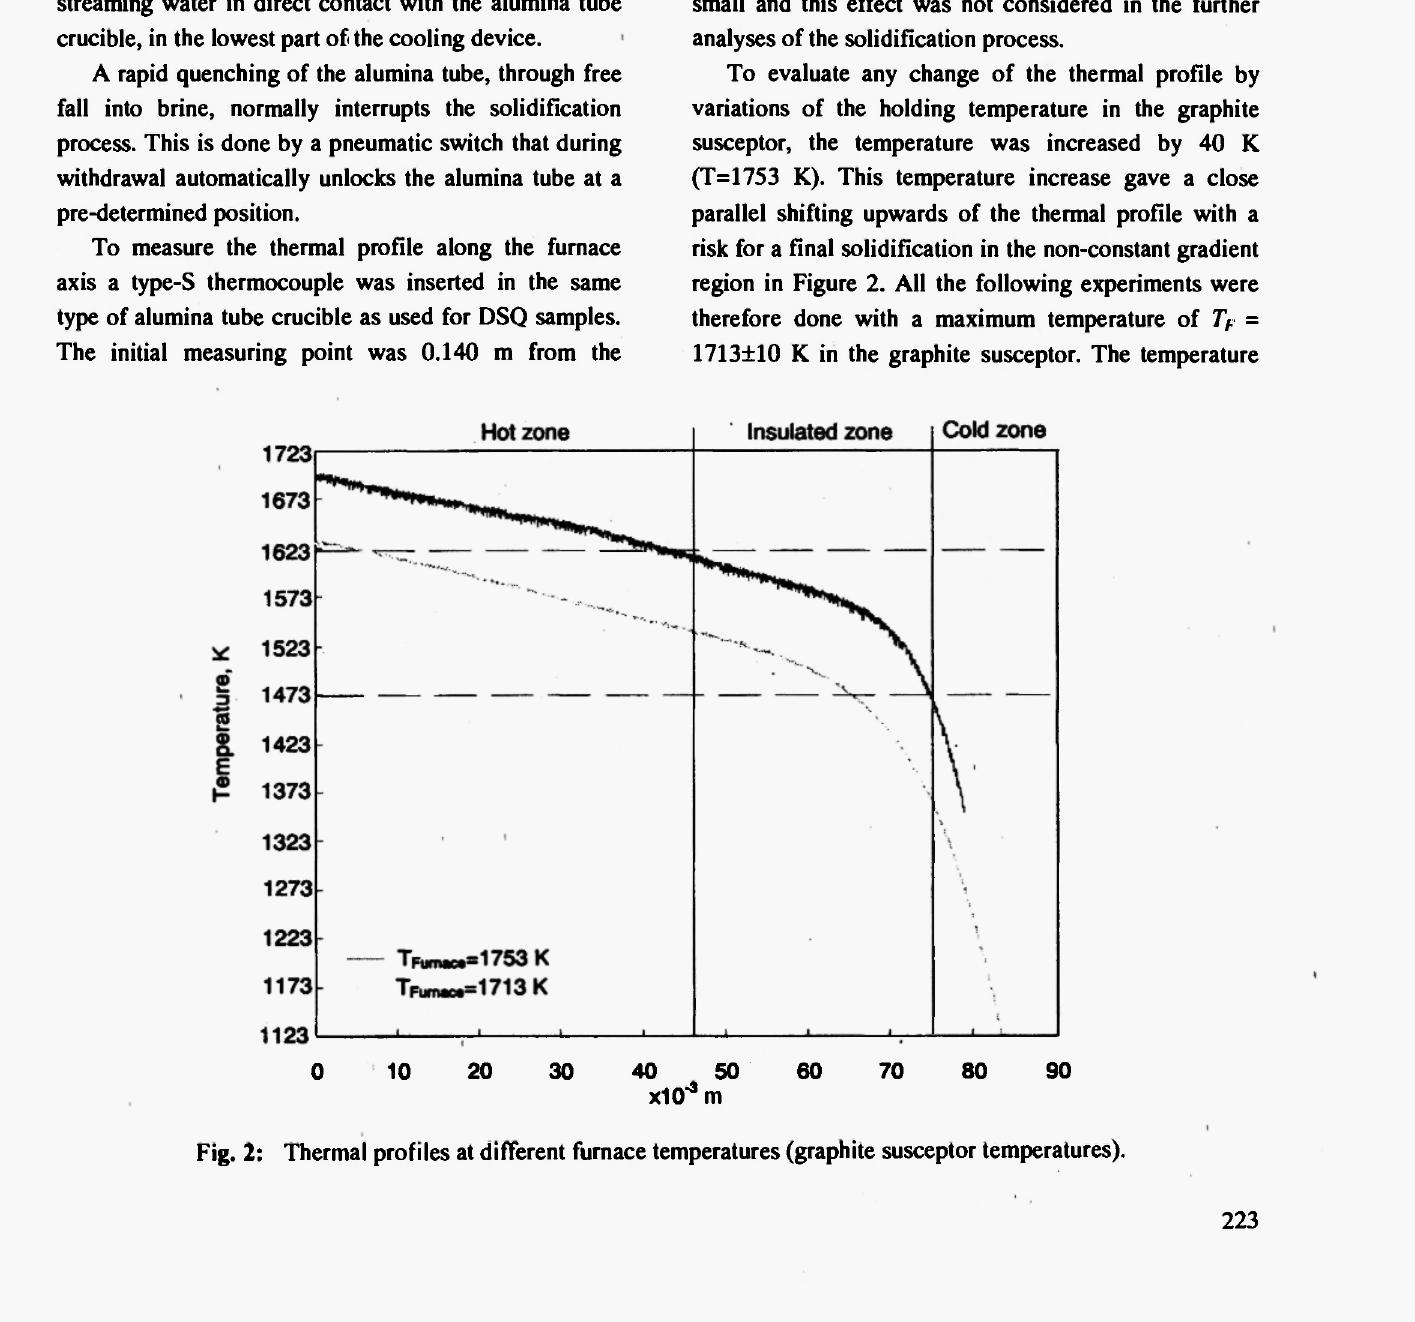
Fig. 2: Thermal profiles at different furnace temperatures (graphite susceptor